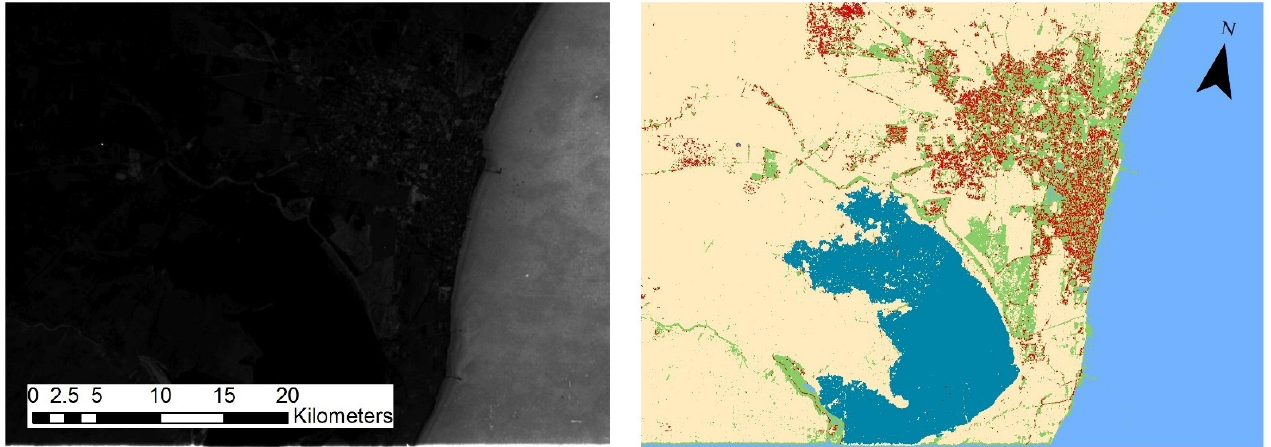
Figure 8. ( Left ): Image quality metric ( ERGAS ) comparing the original CORONA image against the colourised CORONA image. Similarities between the two images are shown with a dark tone, while areas that have changed through the colourisation process are white. ( Right ): the classification outcome of the colourised CORONA image.